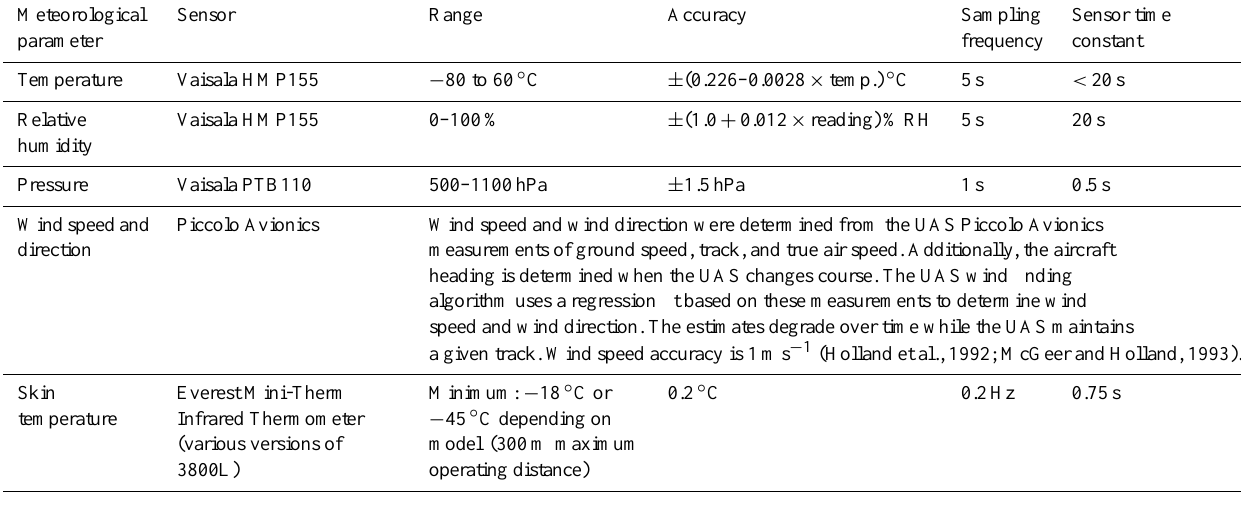
Table 2. Aerosonde instrument specifications.